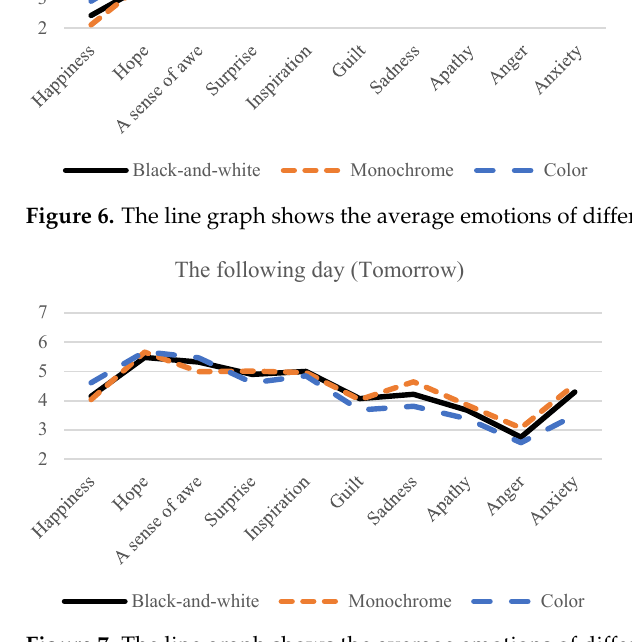
Figure 7. The line graph shows the average emotions of different colors in #2 image.